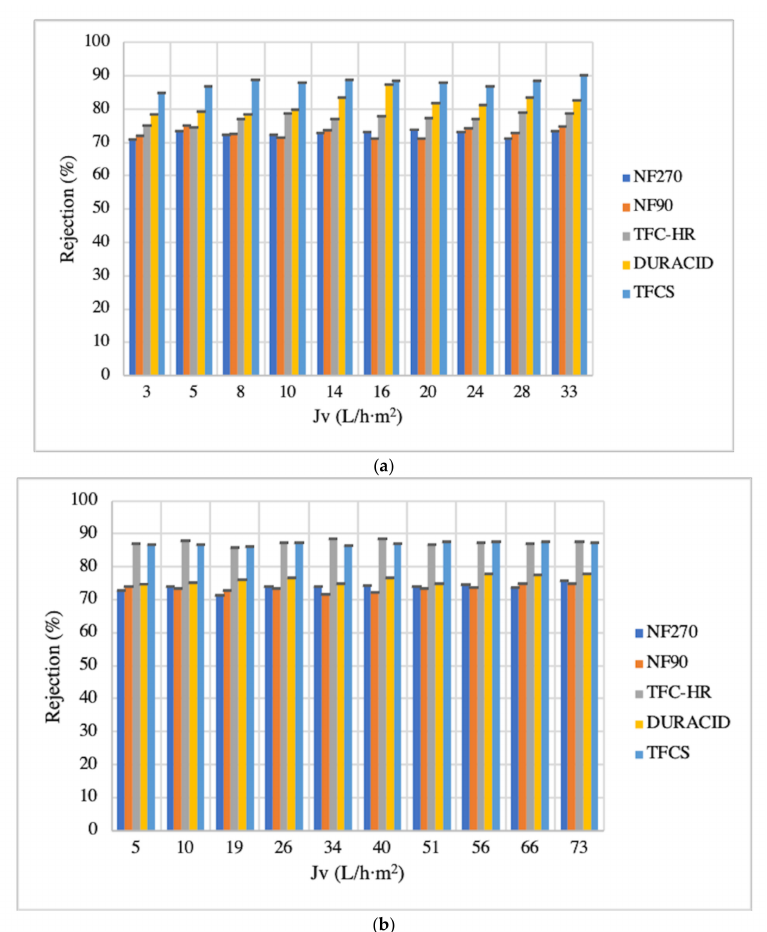
Figure 4. NF rejection evolution with permeate flux of spinach and orange matrices (( a , b ),